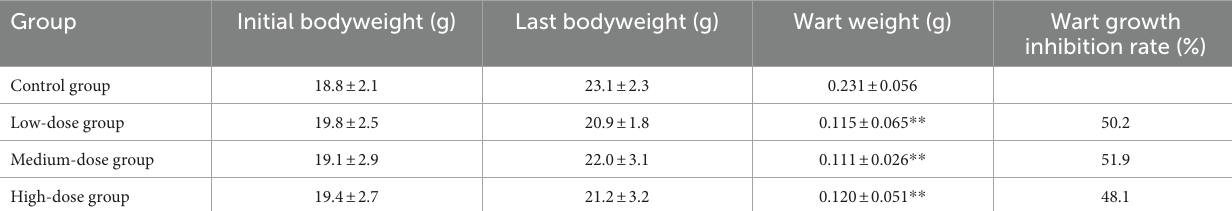
TABLE 2 Effect of chloroquine phosphate gel on body weight and wart weight of condyloma acuminatum-bearing nude mouse model ( n = 6 each group). Group